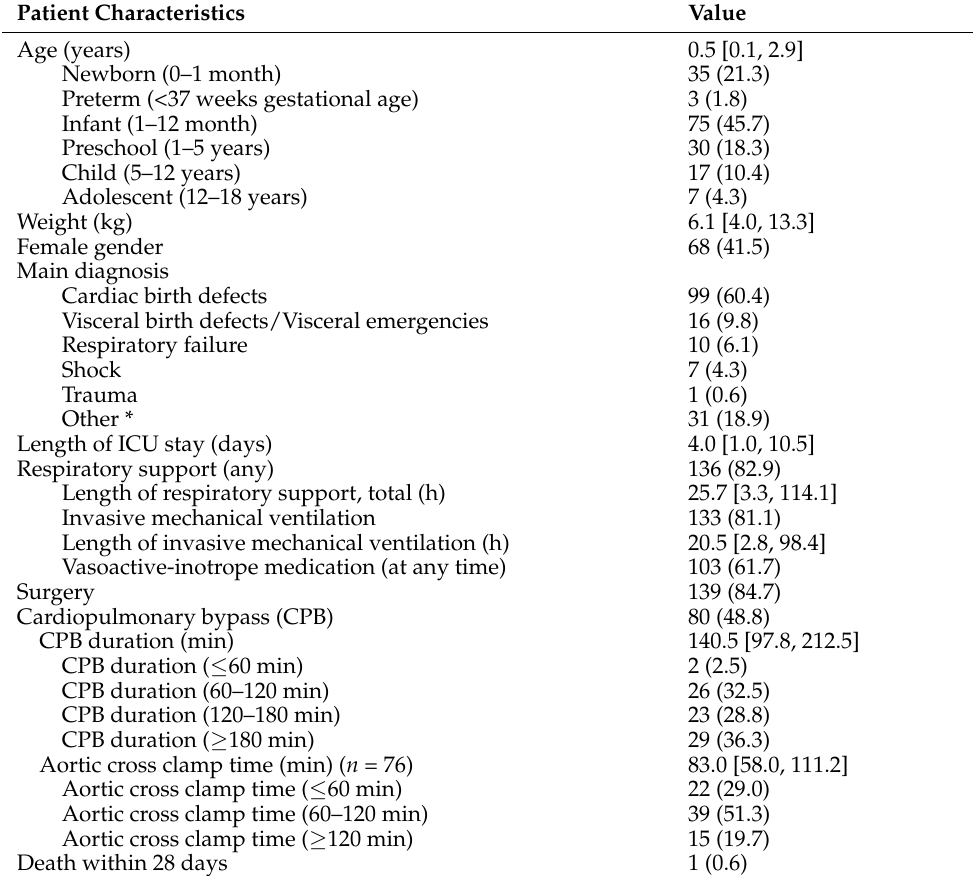
Table 1. Baseline characteristics of the 164 patients included in the analysis.